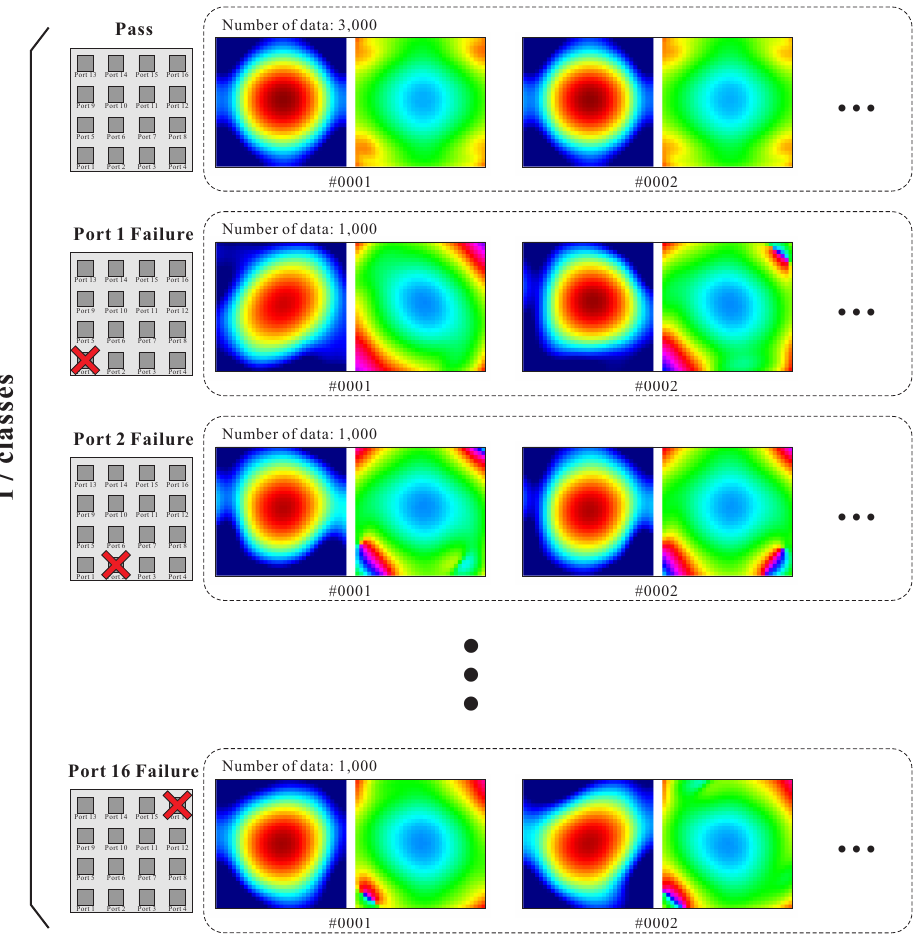
Figure 4. Dataset configuration of specific port failure